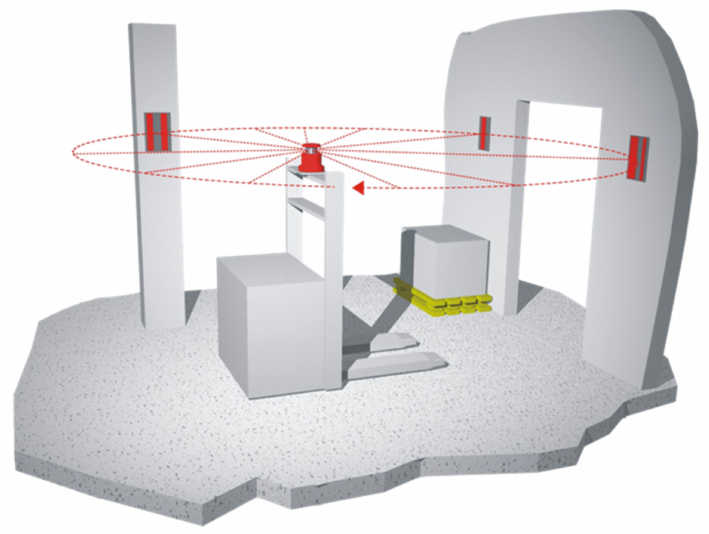
Figure 1. The rotating laser scanner is mounted on the vehicle and measures the reference marks on pillars and walls. Reprinted/adapted with permission from Ref. [21]. 2018, Götting